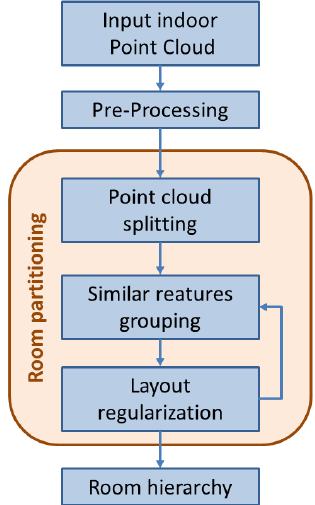
Figure 1. Overview of the workflow for the developed